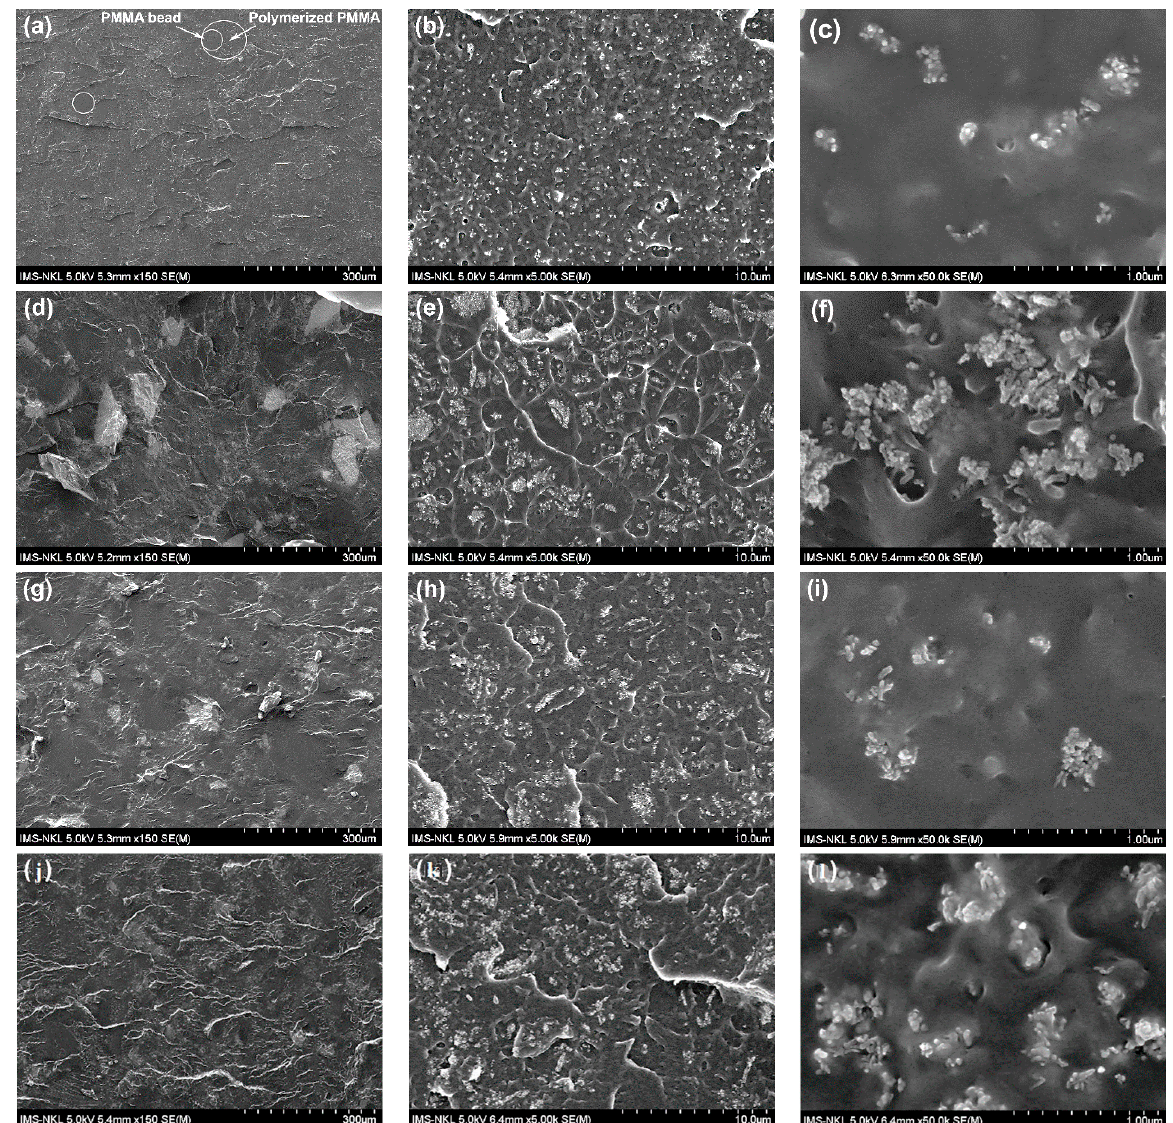
Figure 7. FESEM images of fractured cross-section of unmodified and HAP-modified bone cements: ( a – c ): unmodi- fied-BC, ( d – f ): oHAP10-BC, ( g – i ): vHAP10-BC and ( j – l ): gHAP10-BC. ( d – f ): oHAP10-BC, ( g – i ): vHAP10-BC and ( j – l ):